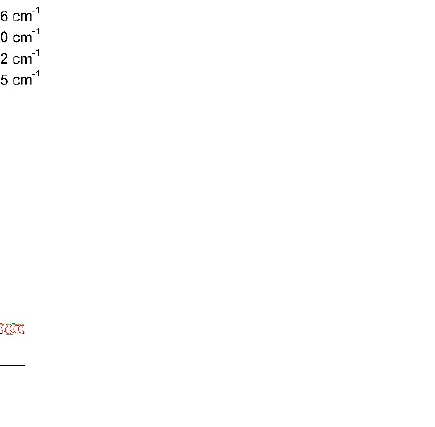
Figure 3. Typical response curves for toluene in supercritical carbon dioxide at different wavenumbers.